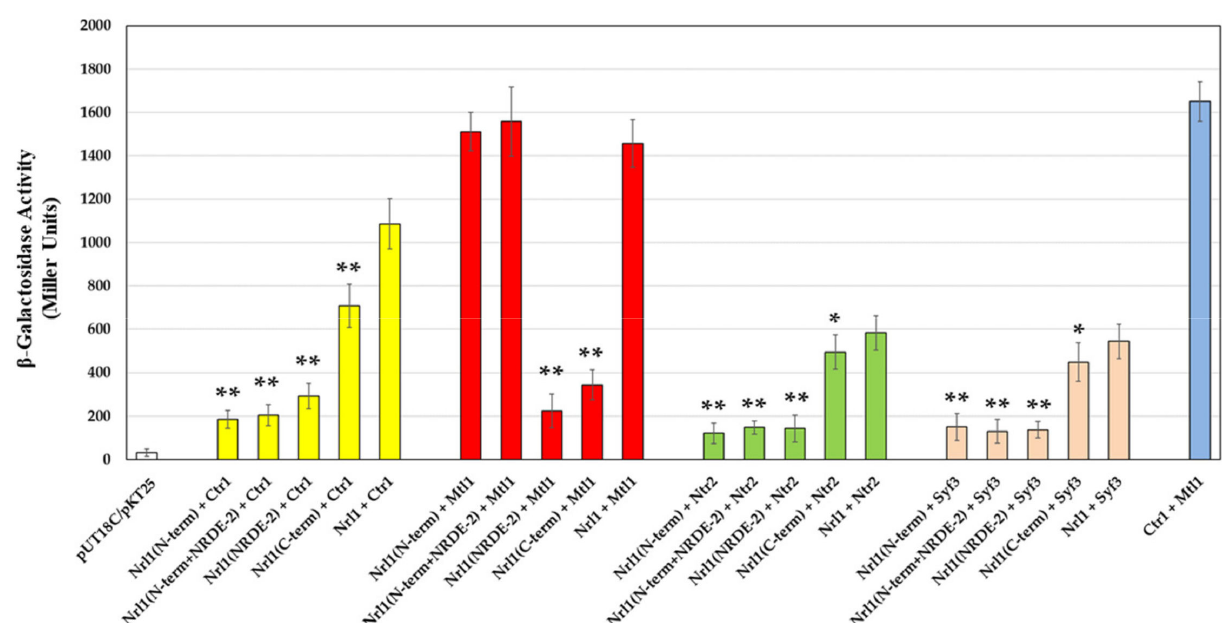
Figure 3. Physical interactions between wild-type Nrl1, truncated Nrl1 proteins, and RNA-processing factors Ctr1, Mtl1, Ntr2, and Syf3 analyzed by BACTH assay. The interaction between the Ctr1 and Mtl1 was used as a positive control. Data represent mean values ± S.D. from eight independent biological replicates. Statistical significance of truncated domain construct interactions compared to Nrl1 and selected RNA-processing factor interactions was determined using one-way analysis of variance (ANOVA) ( p -values: *— p ≤ 0.05 and **— p ≤